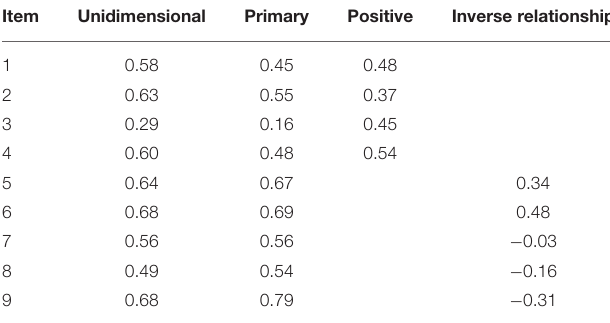
TABLE 5 | Unidimensional and bifactor IRT model